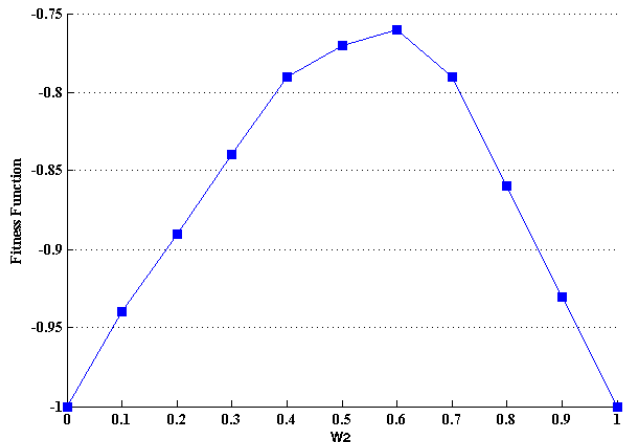
Figure 6. The trend of fitness function versus the weighting factors.